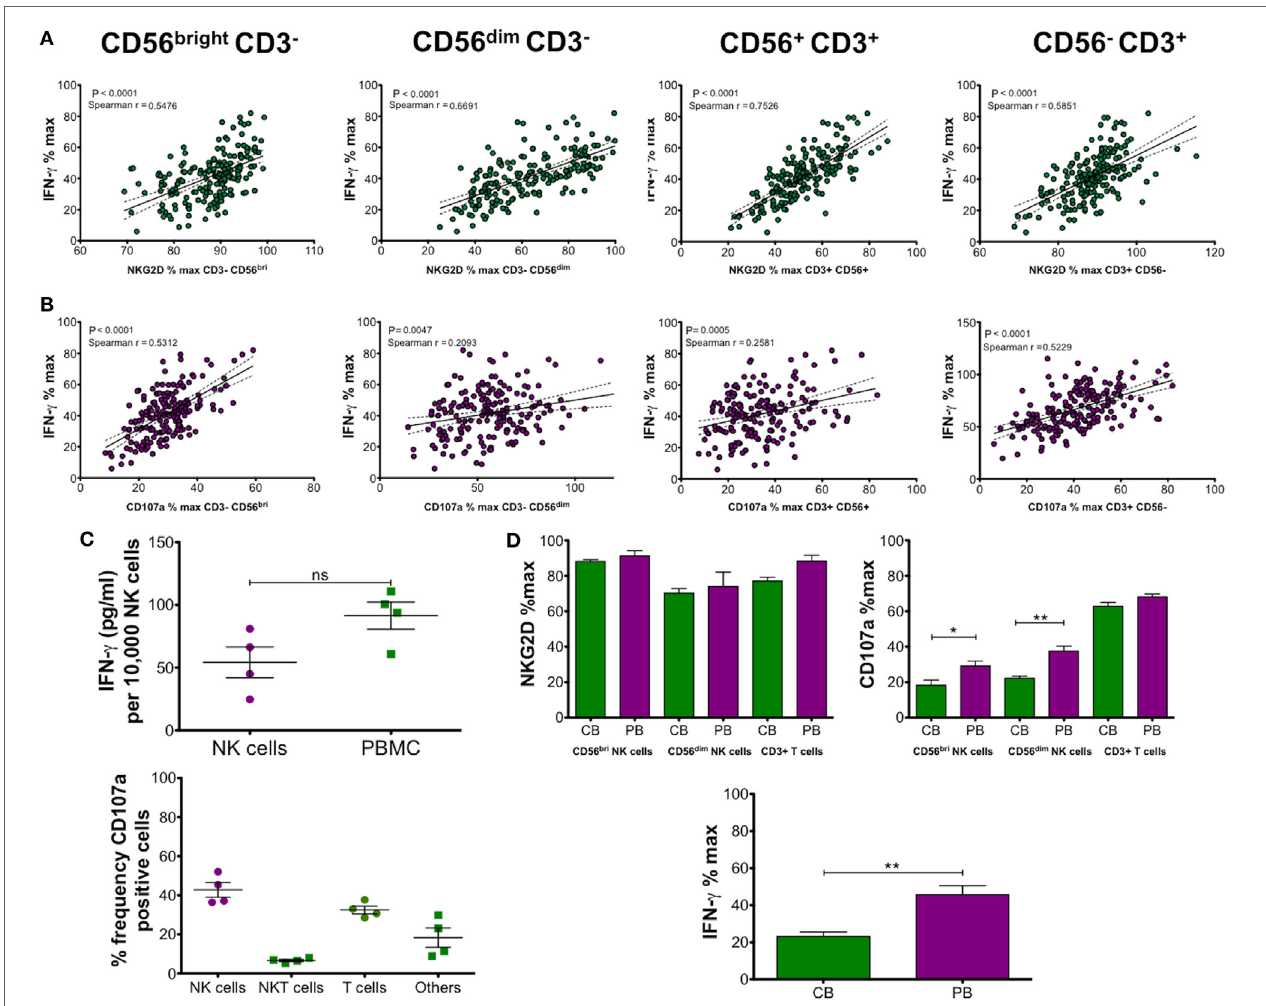
FigUre 3 | (a,B) Correlation and linear regression analysis of NK group 2, member D (NKG2D) and CD107a expression on CD56 bright CD3 − , CD56 dim CD3 − natural killer (NK) cells, CD56 + CD3 + NKT cells, or CD56 − CD3 + T cells with IFN- γ production. Peripheral blood mononuclear cells (PBMCs) were incubated with 50% cord blood plasma (CBP) ( n = 181) or media only for 48 h and then stimulated with PMA and ionomycin. IFN- γ in culture supernatants was measured by ELISA and expression of CD107a and NKG2D on the different cell types was measured by flow cytometry. (c) IFN- γ production by isolated NK cells or PBMCs was measured after CBP incubation and stimulation with PMA and ionomycin. The upper graph shows a comparison of isolated NK cells with PBMCs after calculation of IFN- γ detected by ELISA (pg/ml)/10,000 NK cells. The lower graph shows relative frequencies of CD107a-positive CD56 + CD3 − NK cells, CD56 + CD3 + NKT cells, and CD56 − CD3 + T cells detected by flow cytometry. (D) Comparison of cord blood (CB) and adult peripheral blood (PB) derived mononuclear cells after incubation with equivalent CBP for 48 h and PMA/ionomycin stimulation ( n = 7). NKG2D and CD107a expression relative to media only controls was measured by flow cytometry and IFN- γ detected by ELISA. Each experiment was repeated with four different PBMC donors or cord blood units and data points represent donor means. P -values for Spearman r correlations are indicated (a,B) . Statistical significance (c,D) was determined by Mann–Whitney test ± SEM (* P ≤ 0.05 and ** P <